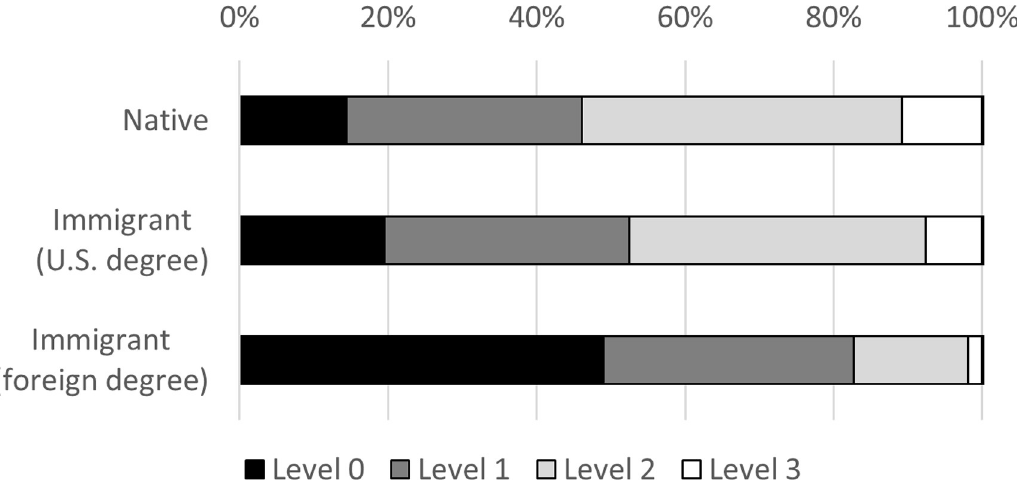
Fig 5. Distribution of PIAAC PSL category scores, education = bachelor’s. The figure displays the percentage scoring at four different levels of the PST test. Higher levels require more sophisticated problem solving. The percentages are not age-adjusted.